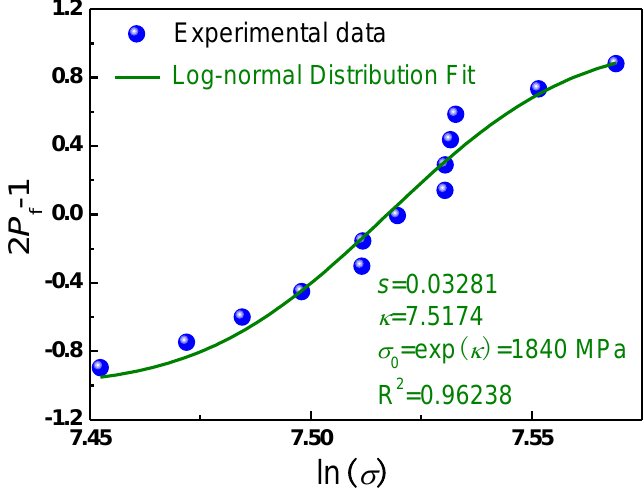
Figure 5. Logarithmic normal distribution fitting curve of the Cu 48 Zr 48 Al 4 amorphous microwires’ fracture strengths.